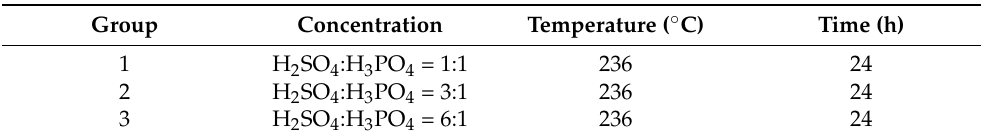
Table 2. Experimental parameters of the wet etching of sapphire hemispheres at different concentra- tions (volume ratios of 98 wt% H 2 SO 4 to 87 wt% H 3 PO 4 ). Group